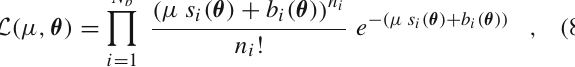
and also the area under the curve (AUC) for all networks are shown in Fig. 13. The AUCs were calculated using y 0 and the trueclasslabels y t